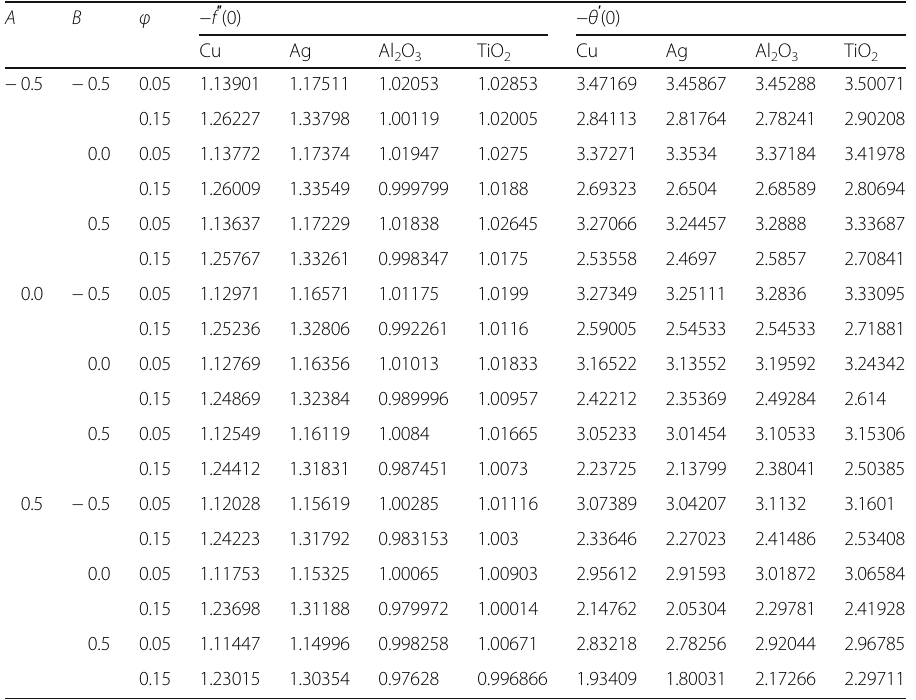
; Pr ¼ 6 : 785 ; λ ¼ 0 : 5 ; and 3